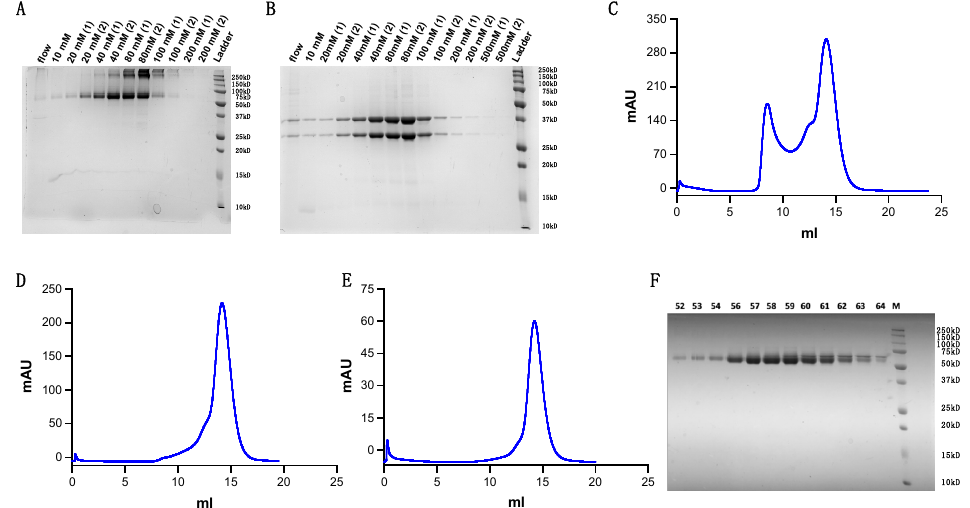
Figure 3. Refolded TCR purification. ( A , B ) Purity evaluation following Ni-NTA column purification at stepwise imidazole concentrations ranging from 10 mM to 200 mM. ( A ) Non-reducing SDS-page gel ( B ) Reducing SDS-page gel ( C ) First round of s200 Superdex SEC. ( D ) Second round of s200 Superdex SEC. ( E ) Third round of s200 Superdex SEC. ( F ) Purity examination of fractions eluted from the final round of SEC.